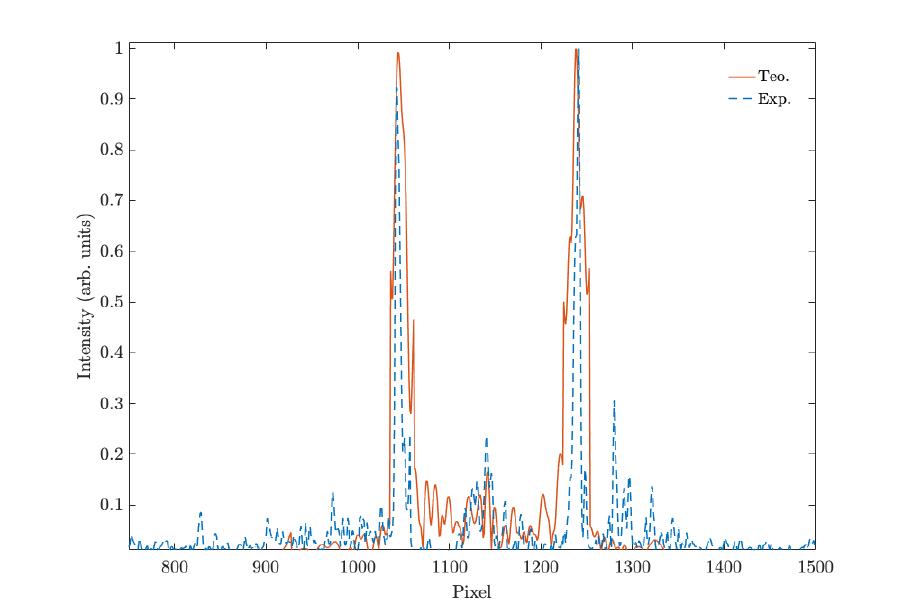
Figure 15. Comparison of intensity measured along a horizontal line of experimental diffraction pattern of helicoidal axicon and theoretical intensity obtained through diffraction